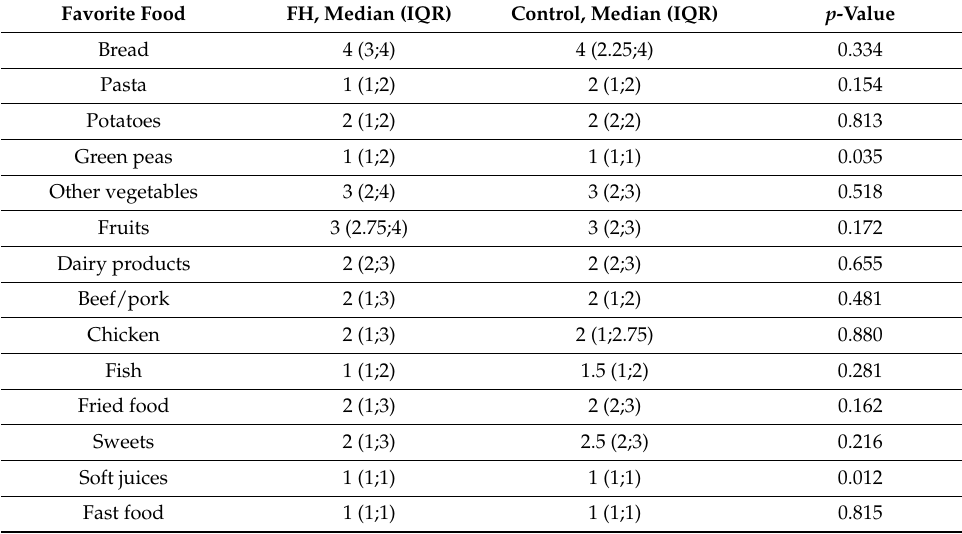
Table 5. Frequency of the eating